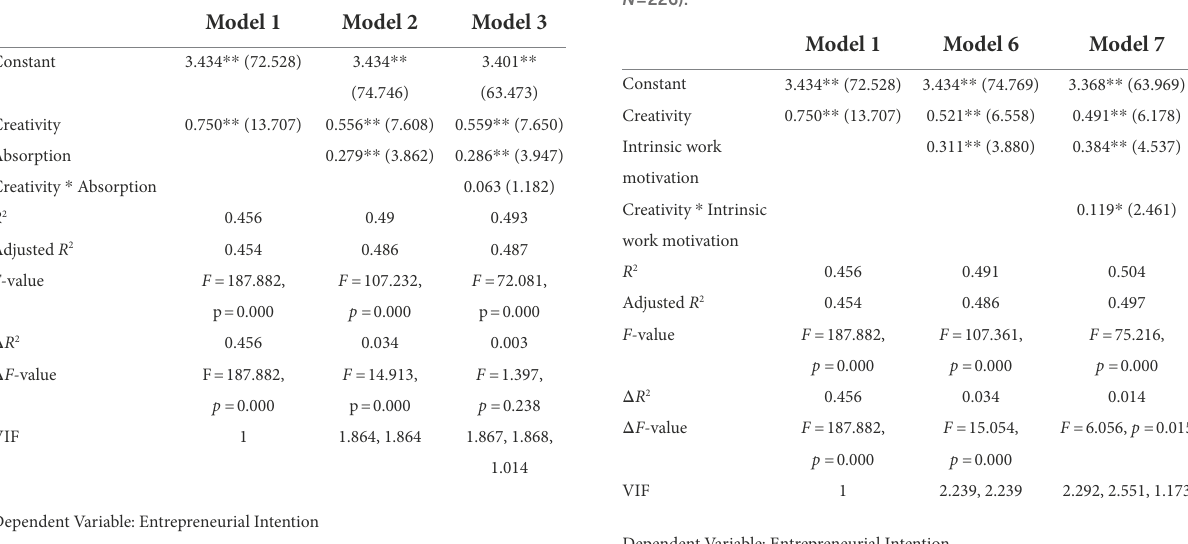
TABLE 5 Moderating effect analysis (flow – absorption; N = 226).